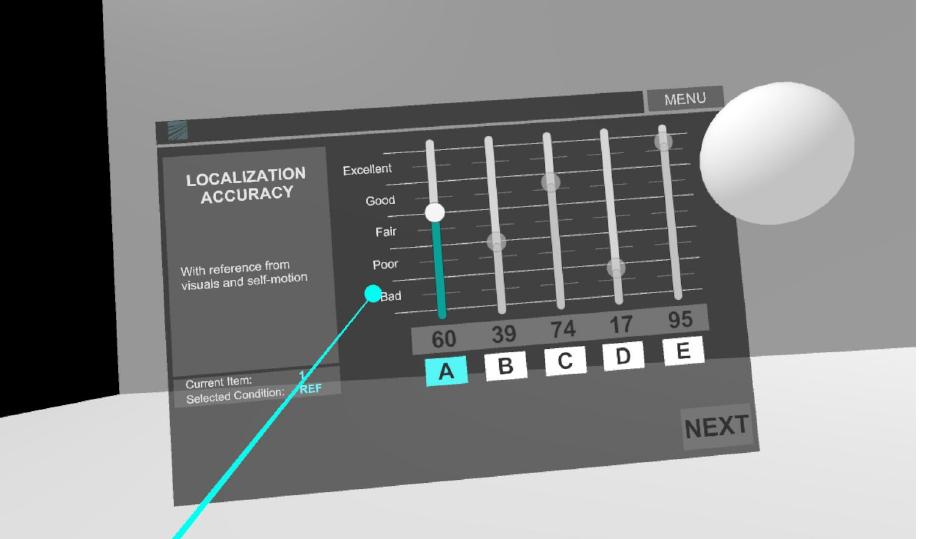
Figure 4. User interface in VR for the localization task. The white sphere denotes visually the location of the audio